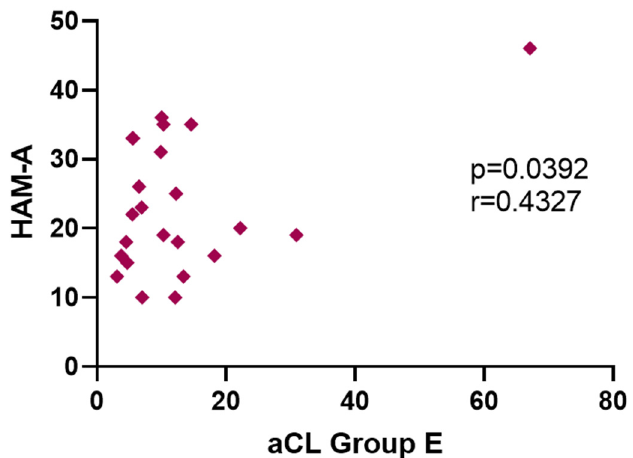
Figure 5. aCL IgM titers of Group E MDD patients in correlation with HAM-A baseline.